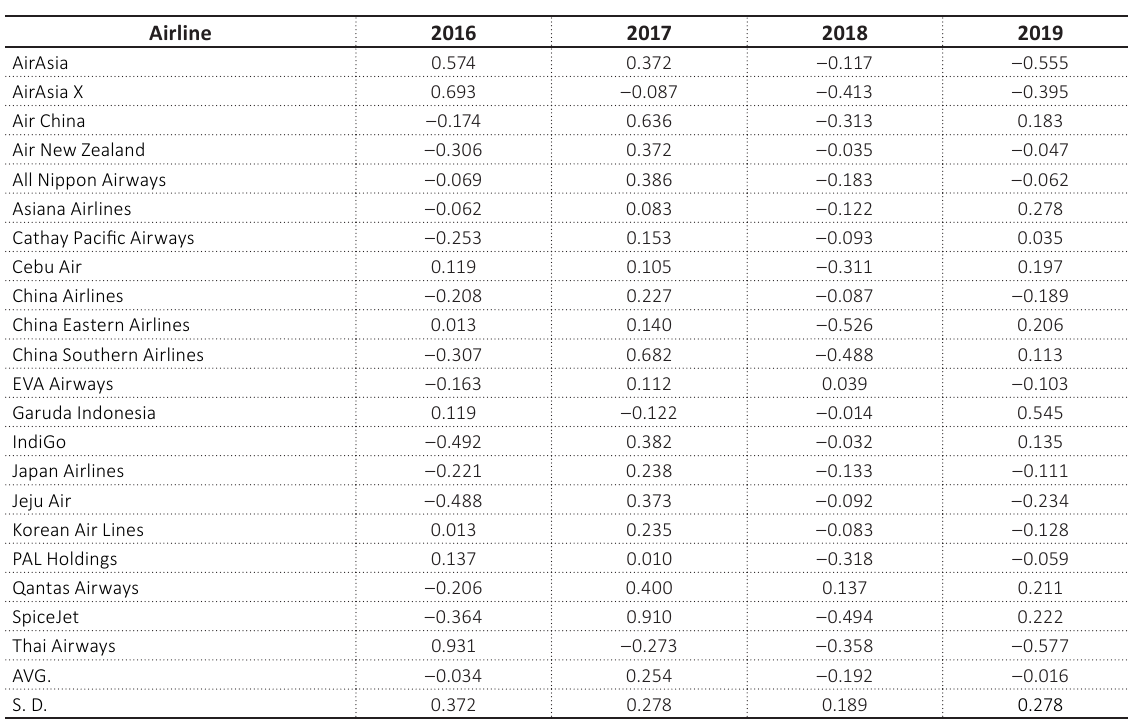
Table 3. Annualized average daily stock returns,